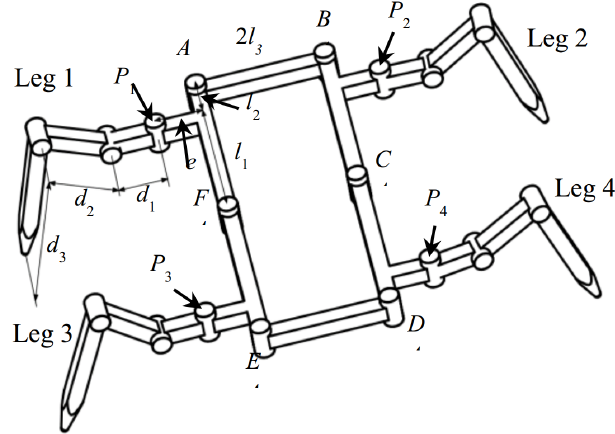
Figure 2. Sketch of the MetaRobot I.